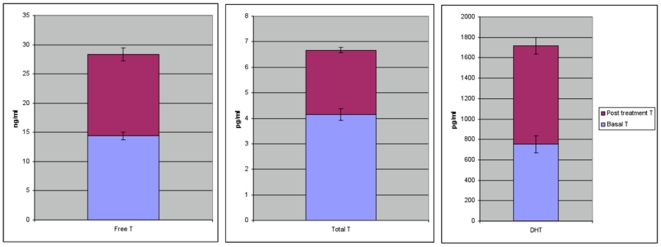
Values of total T, free T, and DHT before and after Androgel® treatment; all differences p<1E-6.The blue bar is basal T and the blue plus the red bar is the post-treatment T value (and SE bars). T in every treated subject was higher than baseline. The highest level of total T after treatment was 10.32 pg/ml or a 170% change from baseline; the smallest change in total T was 0.31 pg/ml or a 7% change.